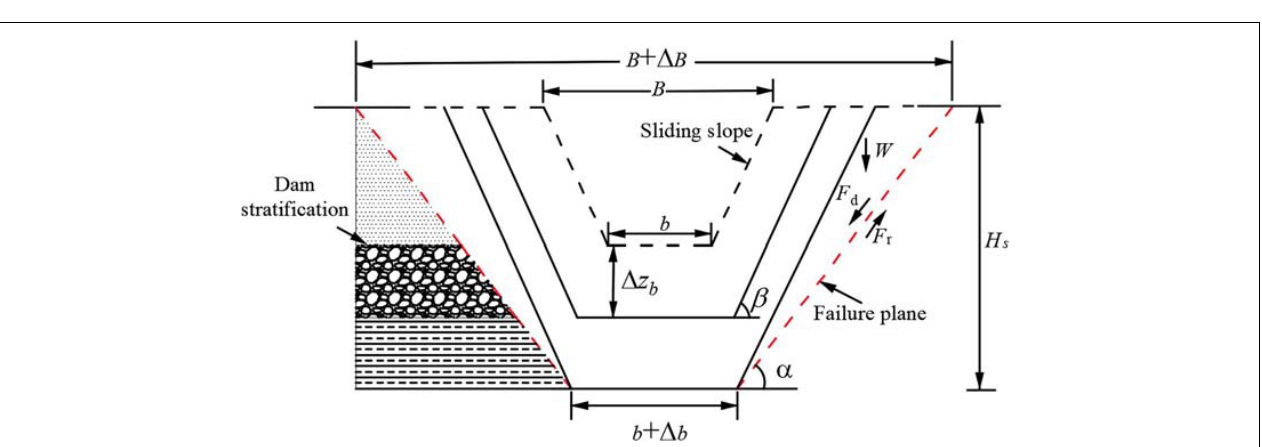
FIGURE 6 | Soil erosion module of the model.